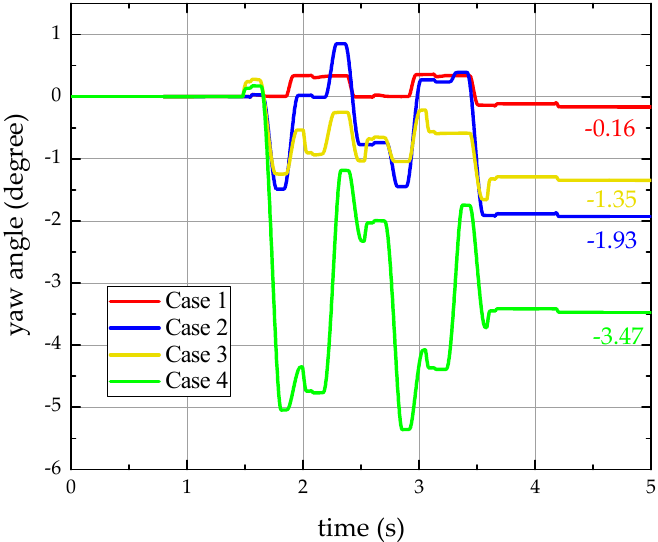
Figure 7. Yaw angle of the robot during walking. It is measured by the IMU. Yaw angle in Case 1 is close to 0. While yaw angles increase in turn in Case 3, Case 2 and Case 4 and they are non-negligible.